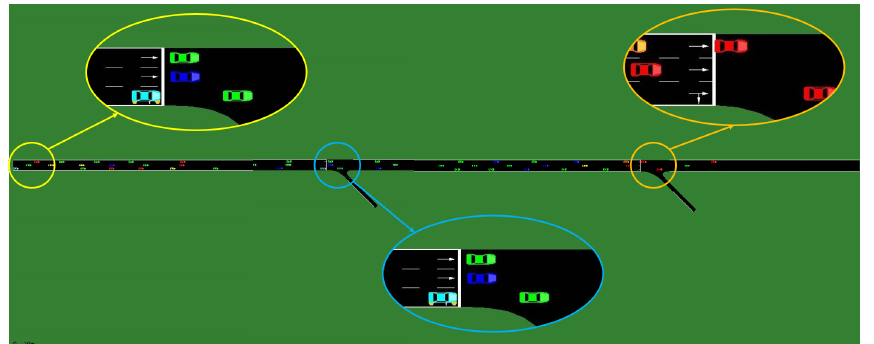
Figure 9. Simulation scenario